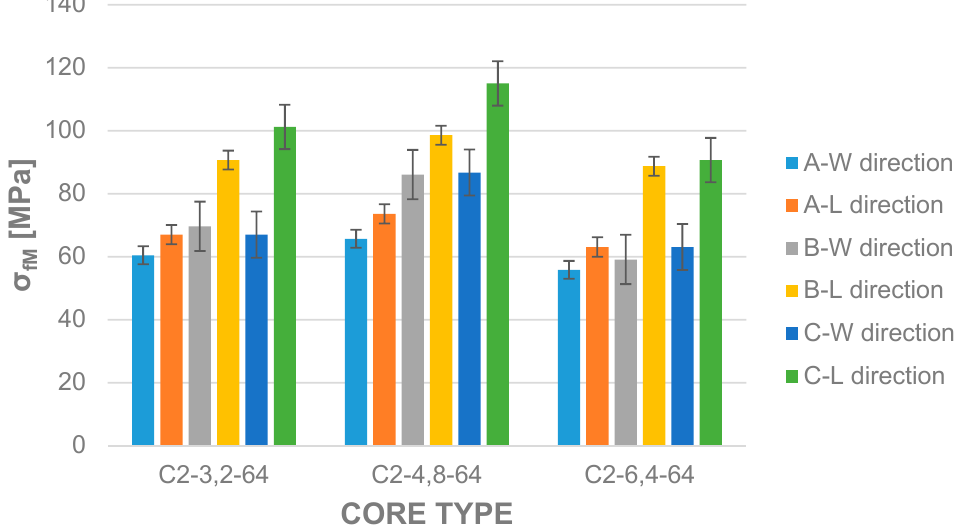
Figure 15. Influence of honeycomb orientations (L and W) with various geometry (mesh sizes 3.2 mm, 4.8 mm and 6.4 mm) on the bending strength of sandwich constructions (types A–C).